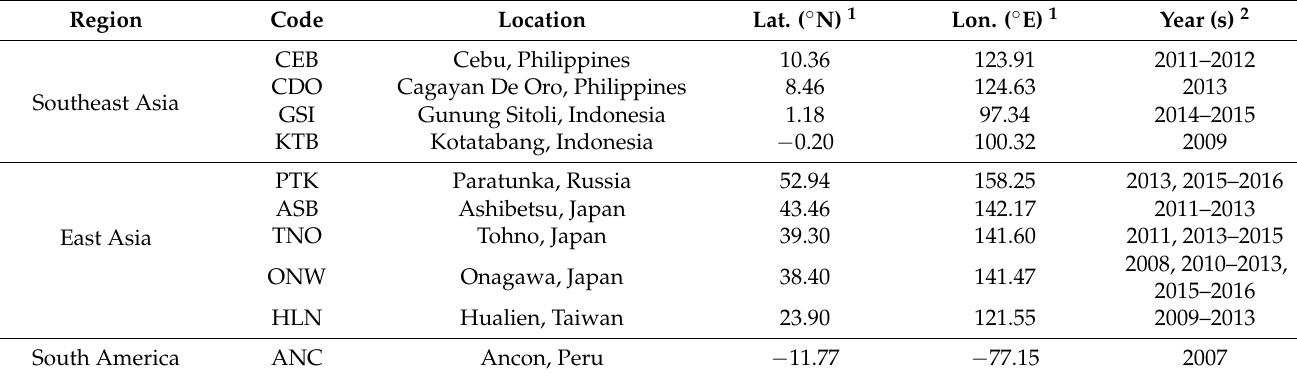
Table 1. Magnetic Data Acquisition System (MAGDAS) station data used in this study. Region Code